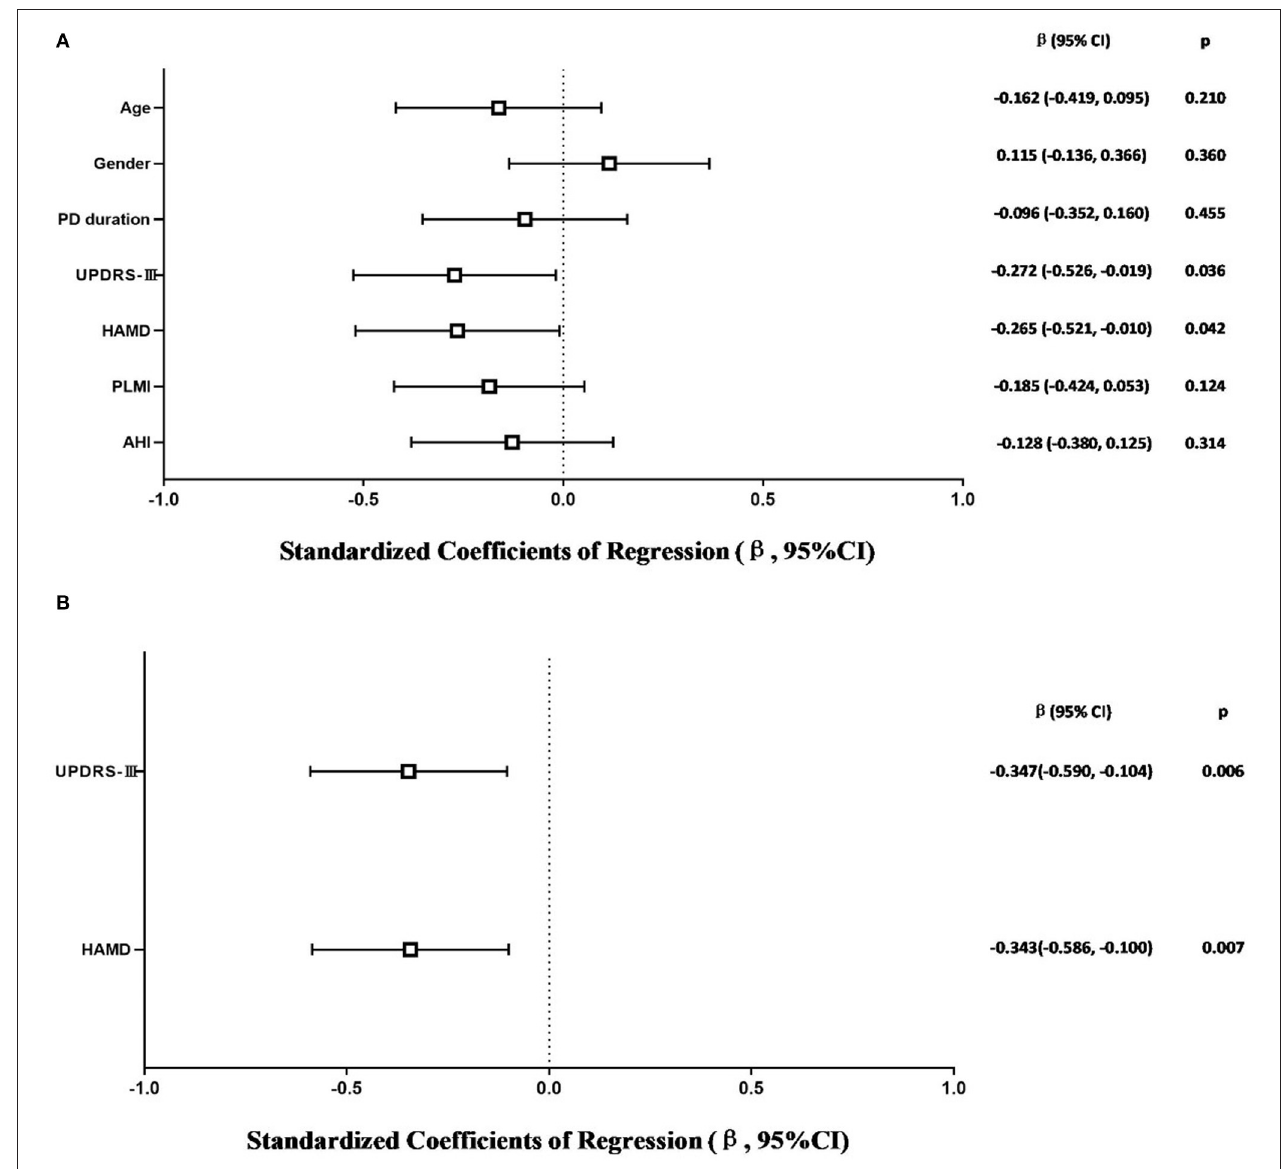
FIGURE 3 | Multiple linear regression analysis of sleep efficiency in PD-NRLS patients. The squares are the standardized regression coefficients ( β , the change in terms of SDs in the dependent variable that results from a change of 1 SD in an independent variable), and the error bars indicate the 95% CI of β . The gender variant was coded as a dummy variable: male was coded 0, and 1 was used for female. PD, Parkinson’s disease; NRLS, without restless legs syndrome; UPDRS-III, Unified Parkinson Disease Rating Scale Part III; HAMD, Hamilton Depression Rating Scale; PLMI, periodic limb movement index; AHI, apnea–hypopnea index. (A) Risk factors of sleep efficiency in PD-NRLS patients. All-factors regression (R 2 = 0.365, p = 0.003). (B) Stepwise regression (Age- and gender-adjusted, R 2 = 0.260, p < 0.001).